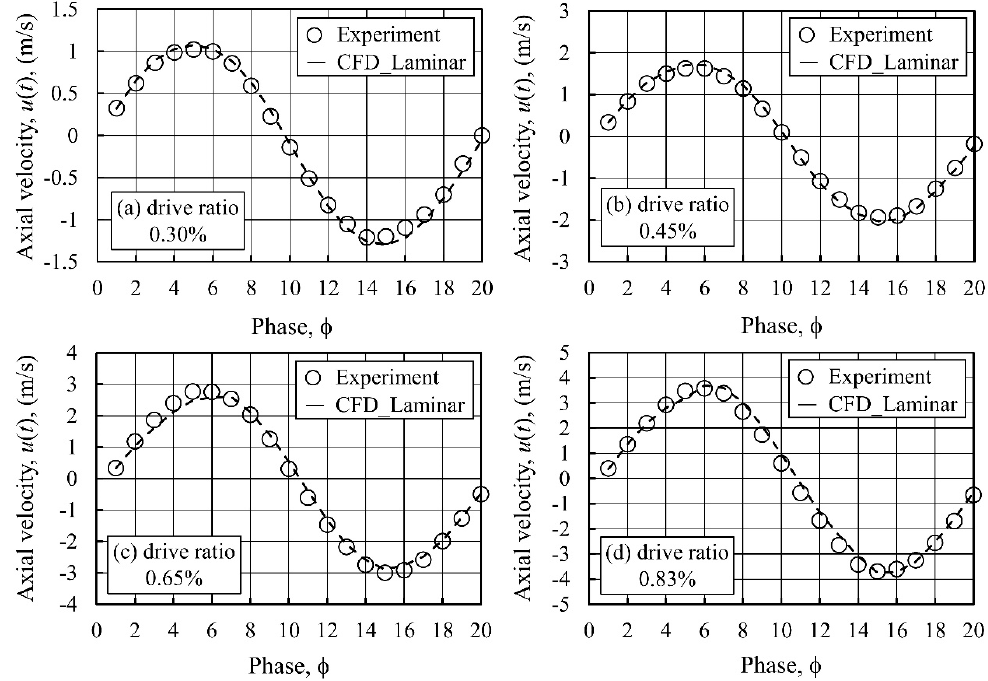
Figure 3. Axial velocity in the middle of the channel at the location 10 mm away from the joint above the cold plate for drive ratios of ( a ) 0.30%, ( b ) 0.45%, ( c ) 0.65% and ( d ) 0.83%.